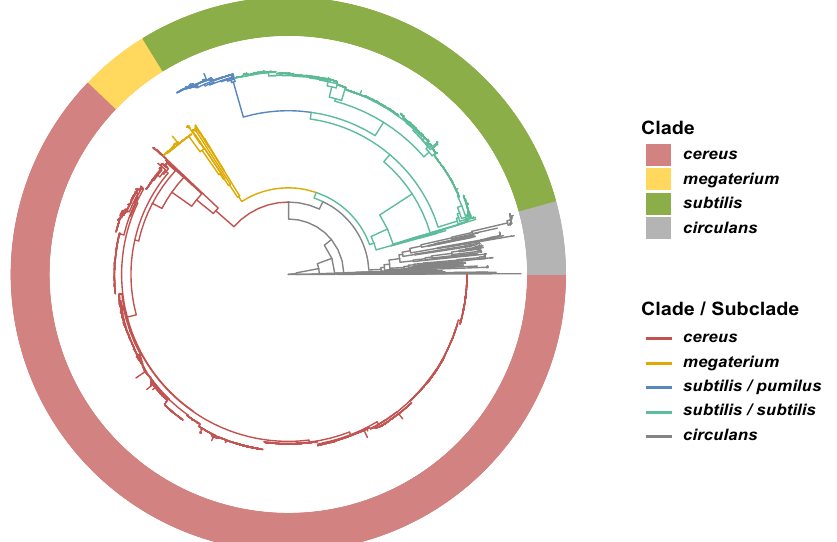
Fig. 1 Phylogram of the tested Bacillus genomes. The maximum likelihood (ML) phylogram of 4268 Bacillus genomes was based on the sequences of 120 ubiquitous single-copy proteins 27 . The phylogenetic tree shows that Bacillus species can be generally clustered into the subtilis (light green circle; further includes subtilis (dark green) and pumilus (blue) subclades as shown in the branches), cereus (red), megaterium (yellow), and circulans (gray) clades. For detailed information of the species, please refer to the phylogenetic tree in Supplementary Fig.